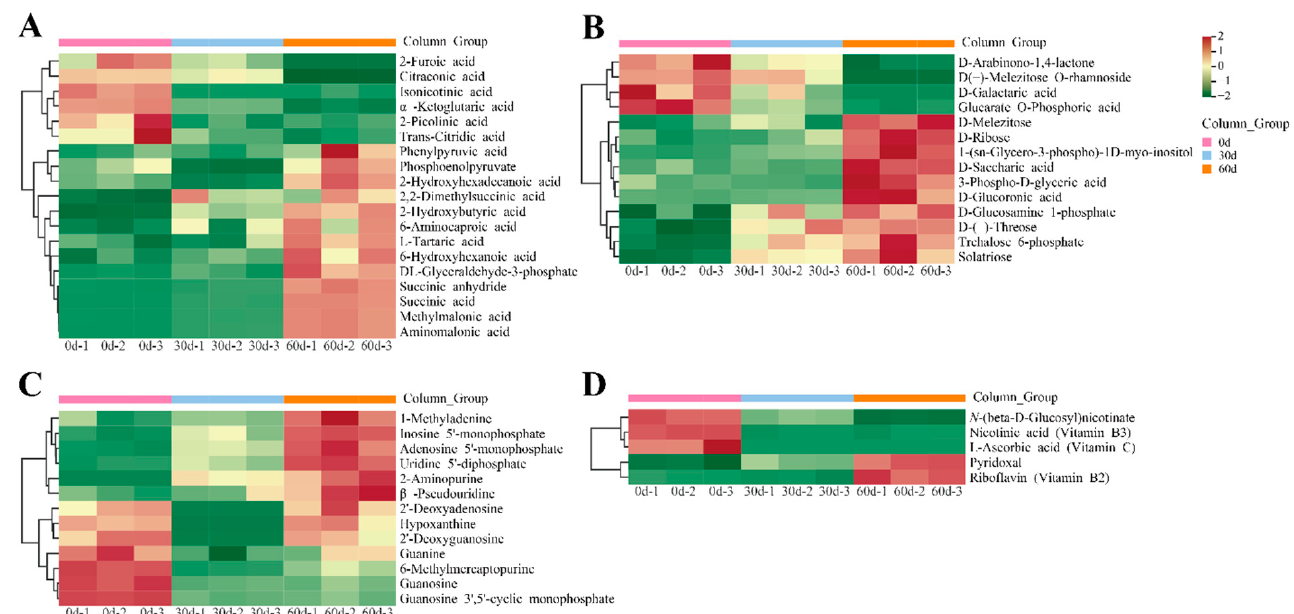
Figure 5. Heatmap of differential metabolites during storage of ‘Fengtang’ plum fruits: ( A ) Heatmap of organic acids, ( B ) Heatmap of saccharides and alcohols, ( C ) Heatmap of nucleotides and derivatives, and ( D ) Heatmap of vitamins.